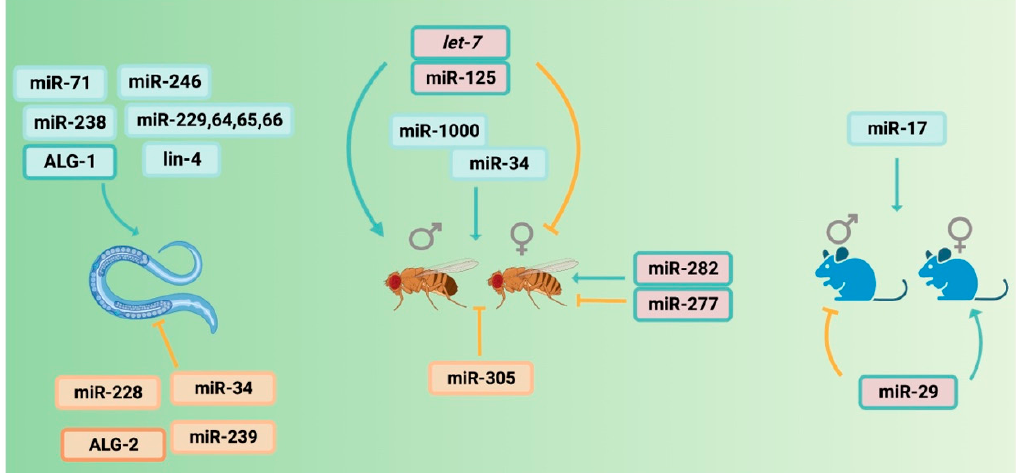
Figure 1. MiRNAs regulating lifespan in nematodes, flies, and mice. Schematic represents miRNAs that regulate lifespan (either positively or negatively) in C. elegans , Drosophila melanogaster , and Mus muluscus. In flies and mice, miRNAs regulating lifespan in a sex-specific manner are shown via different arrows (blue: promote lifespan, orange: inhibit